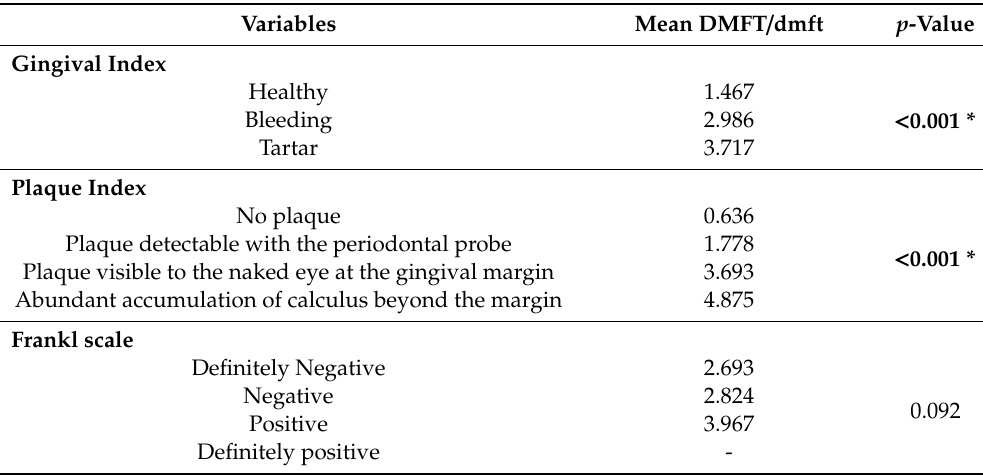
Table 5. Caries severity in relation to Gingival Index, Plaque Index, and ASD severity (measured as the Frankl scale rating). p -values < 0.05, corresponding to statistically significant di ff erences, are marked with an asterisk and the corresponding variable is highlighted in